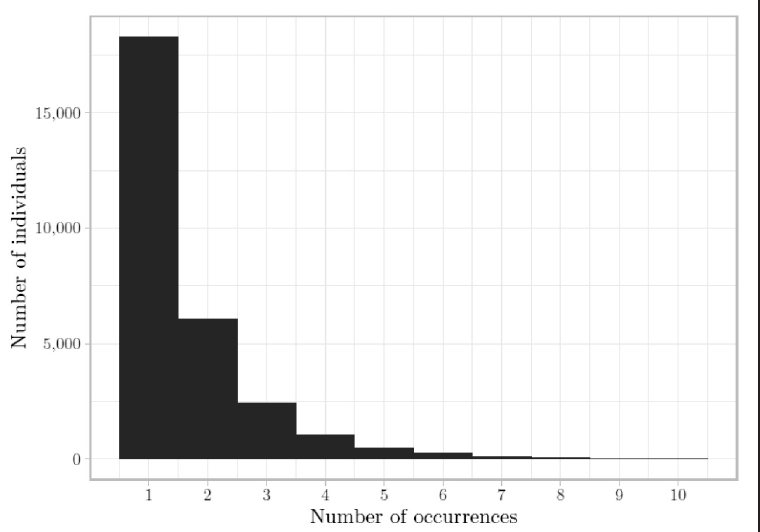
Number of appearances of individuals in the entrepreneurial sample.